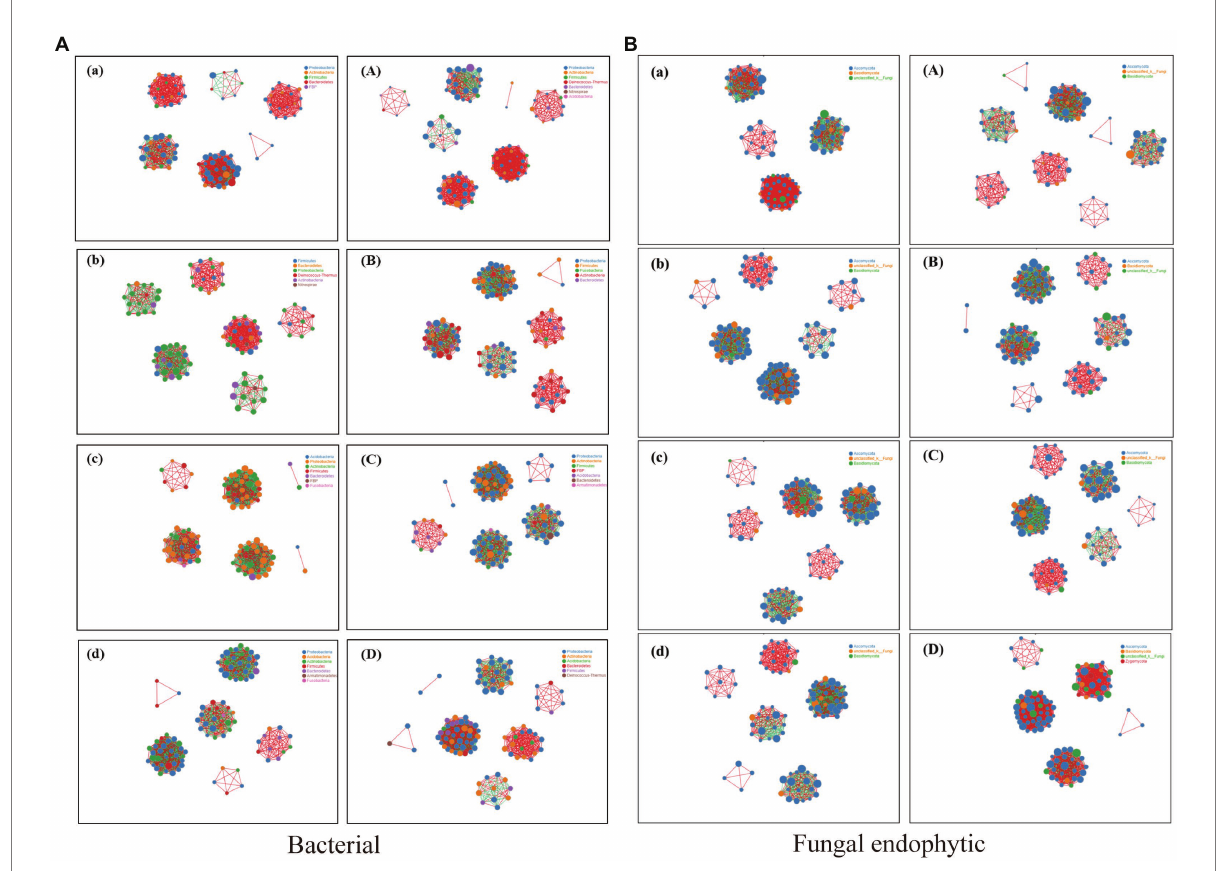
FIGURE 7 Network analysis showing the correlations between bacterial and fungal endophytic communities. (The figure shows the species with Spearman coefficient > 0.8 and p < 0.01 by default; the size of the node in the figure indicates the species abundance, and different colors indicate different species; the color of the line indicates a positive and negative correlation, and red indicates a positive correlation. Green indicates a negative correlation; the thickness of the line indicates the size of the Pearson correlation coefficient. The thicker the line, the higher the correlation between species; the more lines, the closer the relationship between the species and other species.) (A) Network analysis of correlation between BXZ and endophytic bacteria. (B) Network analysis of correlation between MF and endophytic bacteria. (a) BXZ new leaf; (b) BXZ old leaf; (c) BXZ stem; (d) BXZ root system; (A) MF new leaf; (B) MF old leaves; (C) MF stem; (D) MF root